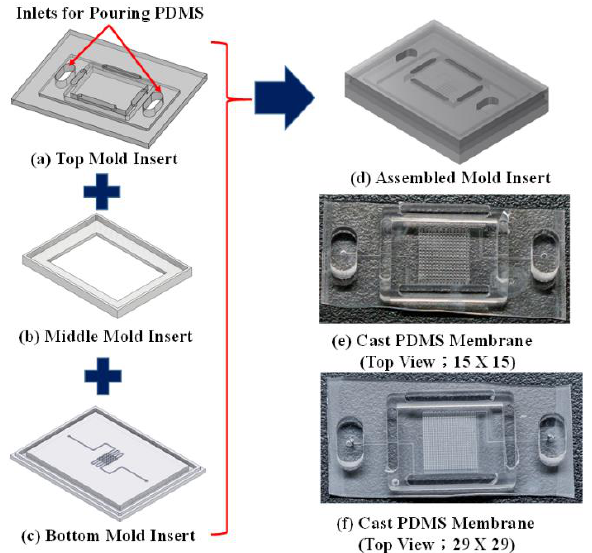
Figure 5. Hybrid mold used to create PDMS membrane: ( a ) top PMMA mold; ( b ) middle PMMA mold; ( c ) bottom PDMS mold shown in Figure 4a,b; ( d ) hybrid assembled mold; ( e ) cast PDMS membrane based on Design I; and, ( f ) cast PDMS membrane based on Design II.